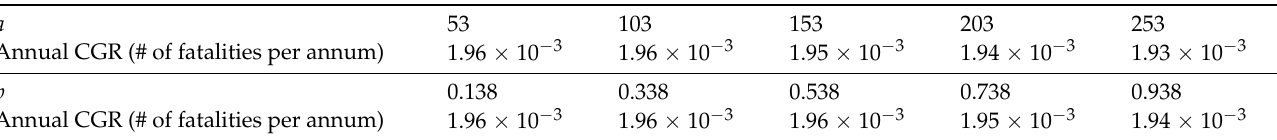
Table A2. Annual CGR with different a and b